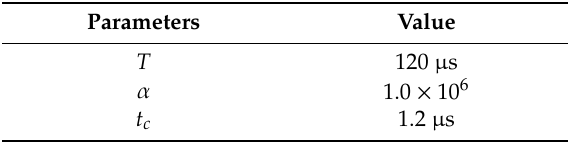
Table 4. The parameters of the hybrid full matrix, f i , j ( t )